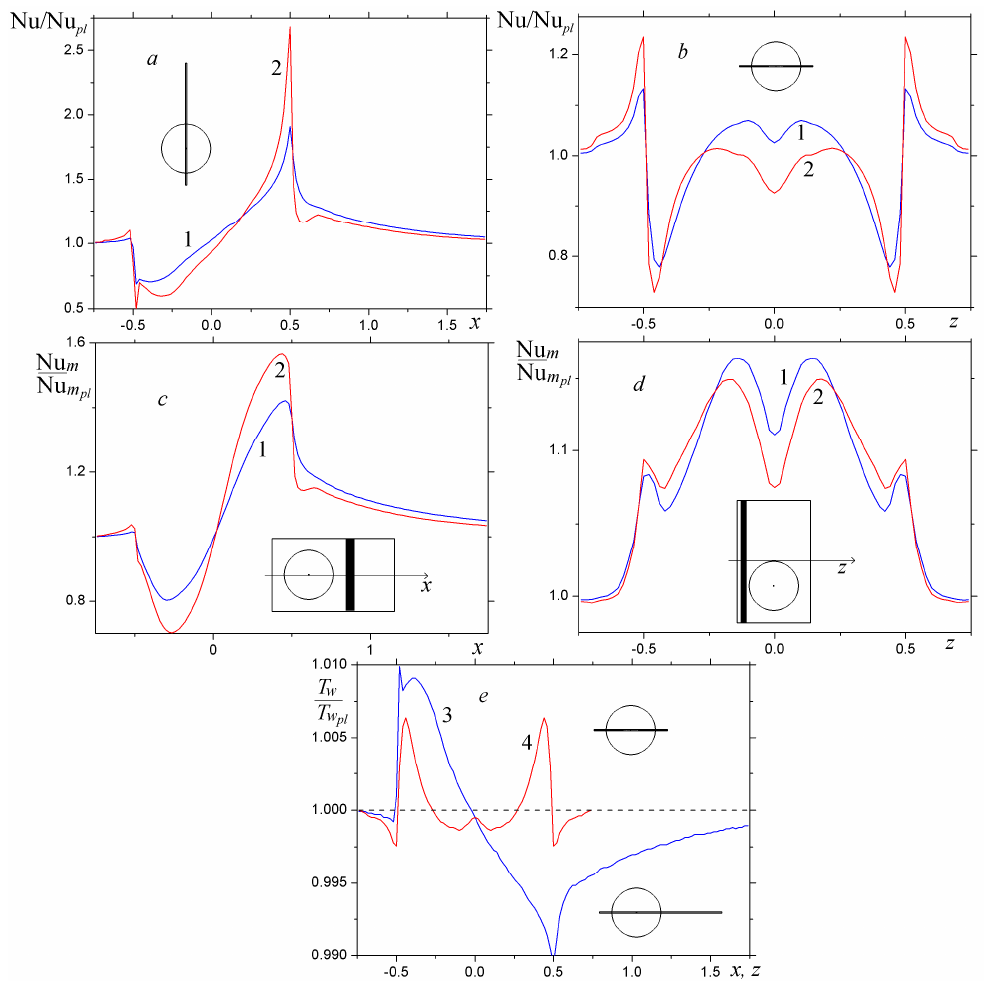
Figure 6. Calculated distributions of relative Nusselt numbers: local ( a , b ) and integrated over transverse ( c ) and longitudinal ( d ) strips of the selected section, as well as of relative wall temperature ( e ) in longitudinal ( a, c, 3 ) and transverse ( b, d, 4 ) middle sections of the dimple at different boundary conditions q = const (curves 1, 3, 4) and T = const (curves 2) at the heated wall of the narrow channel as in V.I. Terekhov’s setup. Energies 2019 , 12 , x FOR PEER REVIEW 12 of 25